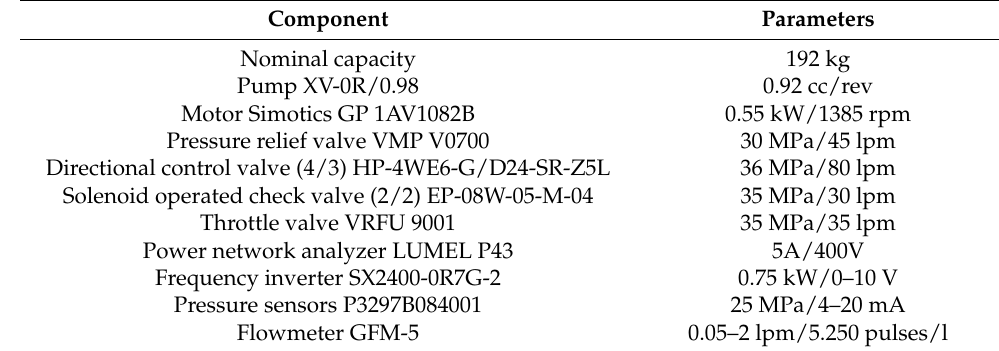
Table 1. Parameters of the system.